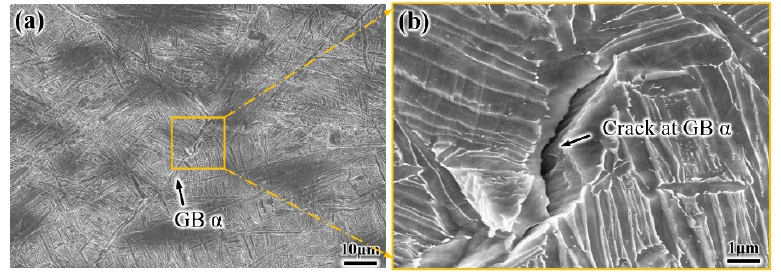
Figure 14. ( a ) Cracks preferentially initiate at GB α of the S-EM and ( b ) Magnified region of ( a ). Furthermore, based on the observation and measurement of at least 100 cracks, the crack initiation probability at different sites in the EM and S-EM was obtained during in situ tensile tests, as shown in Figure 15. The probability of crack initiation in the semi-equiaxed α p phase (include the blurry semi- α p / β trans interface) of the S-EM is lower than the equiaxed α p phase (include the α p / β trans interface) of the EM, whereas the crack initiation probability increased in the β trans microstructure and GB α of the S-EM in comparison to the EM. This indicates that the special interfacial microstructure of S-EM leads to the reduction of local stress concentration at the blurry interface between semi-equiaxed α p phase and β trans microstructure compared to the α p / β trans interface in the EM.